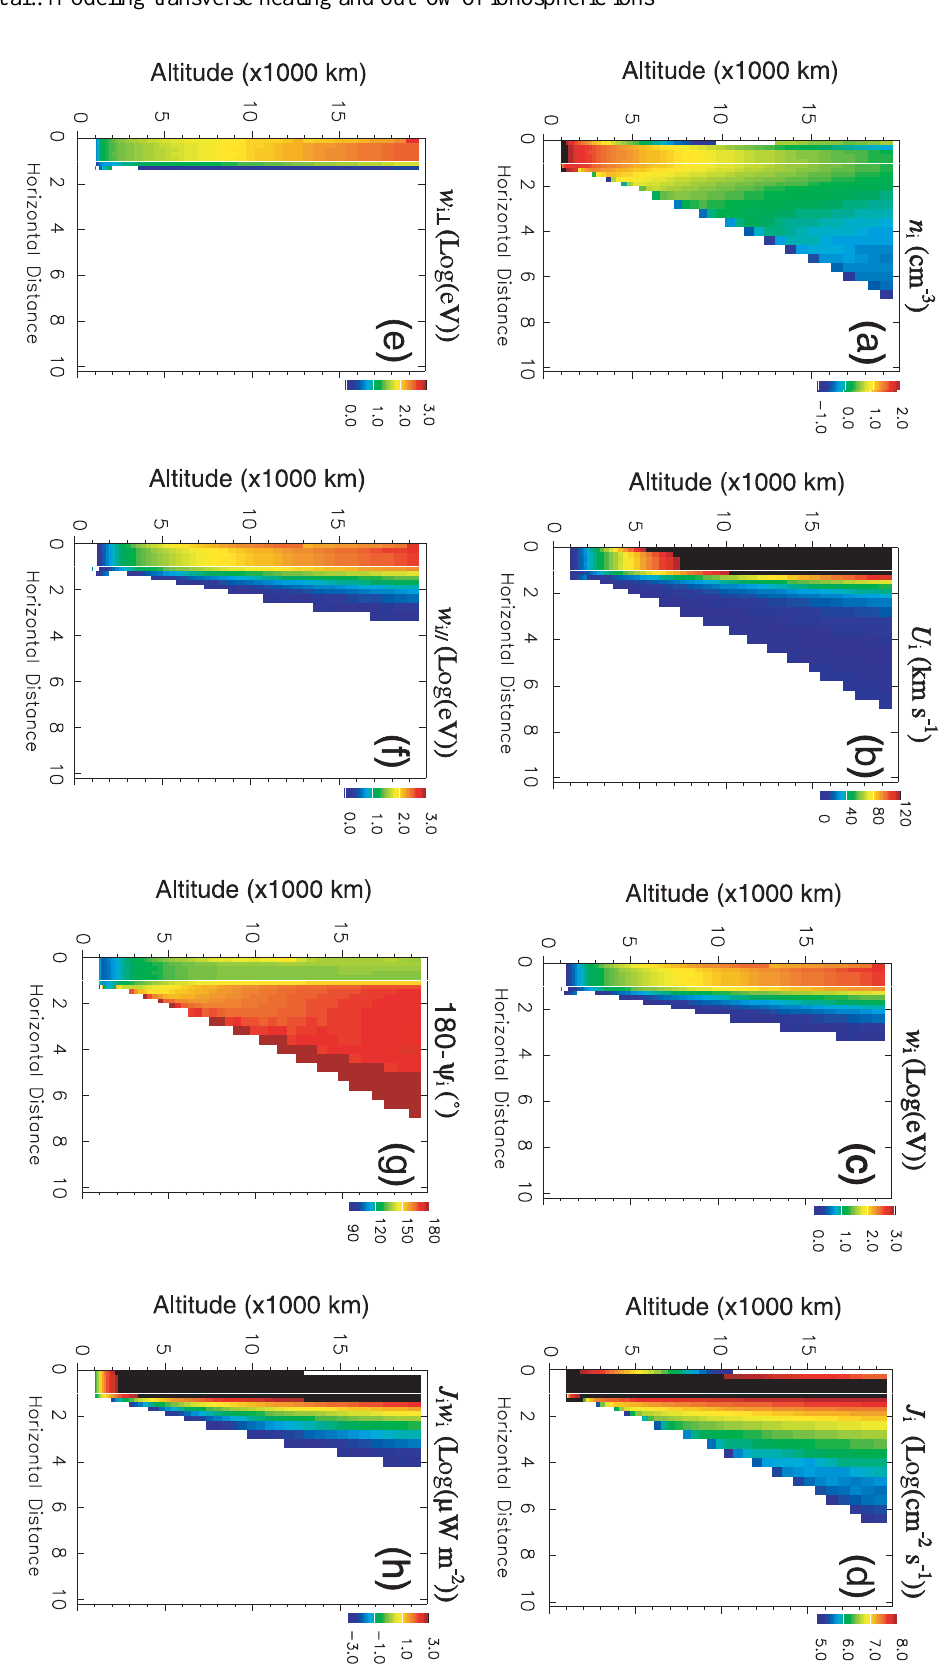
Fig. 3. Transport patterns of H + moments in the ( X,s ) plane. The format is the same as in Fig.